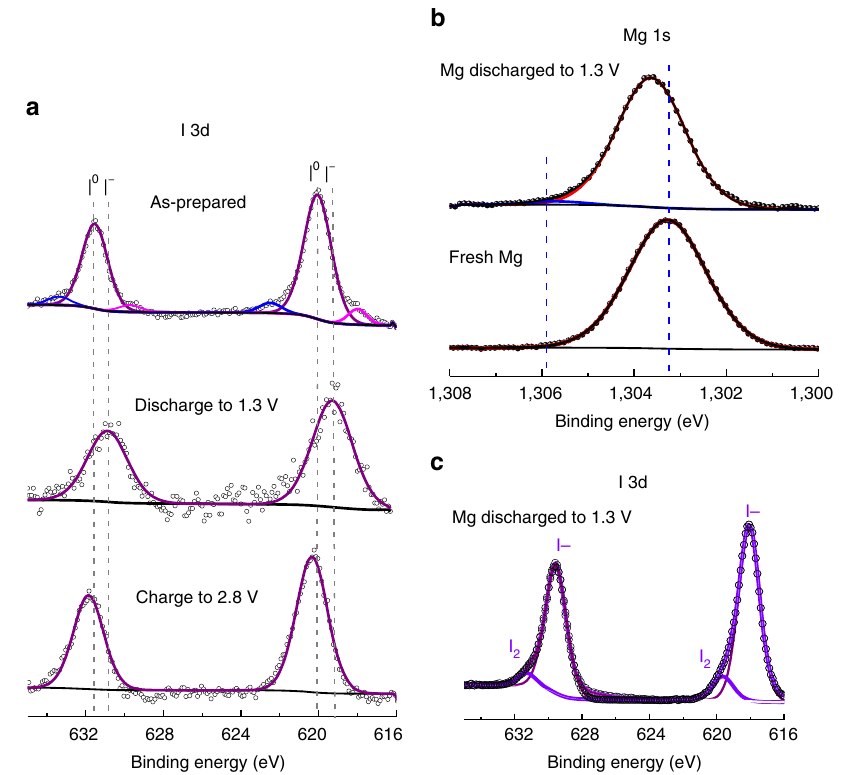
Figure 5 | X-ray photoelectron spectroscopy study of the cathode and anode. ( a ) High-resolution I 3d spectra of the ACC/I 2 cathode. ( b ) High-resolution Mg 1s spectra and ( c ) high-resolution I 3d spectrum of the Mg anode.